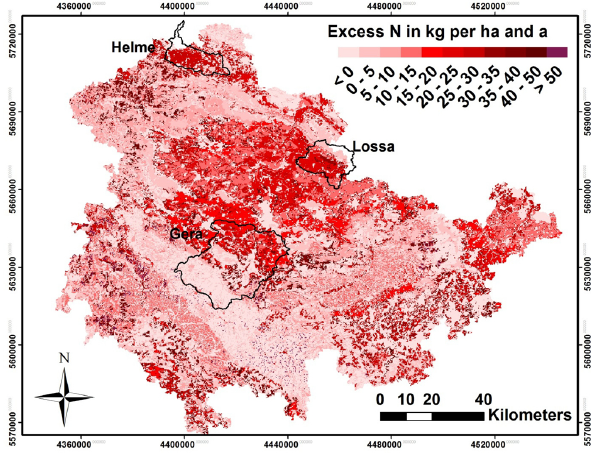
Fig. 7. Regionalized excess nitrogen in kgNha − 1 a − 1 for the whole state of